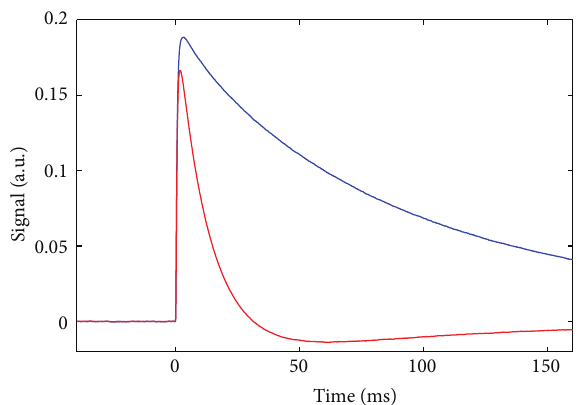
Figure 1: (Color online) low temperature detector setup with a 216 g CaMoO 4 crystal and an MMC sensor. Figure 2: (Color online) a typical signal of 2.6 MeV gamma-ray full absorption events at 40 mK in DC (blue, bigger) and AC (red, smaller) coupling.